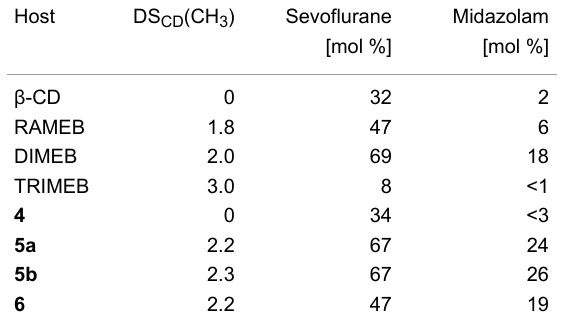
Table 2: Occupancies for methylated CDs and CD